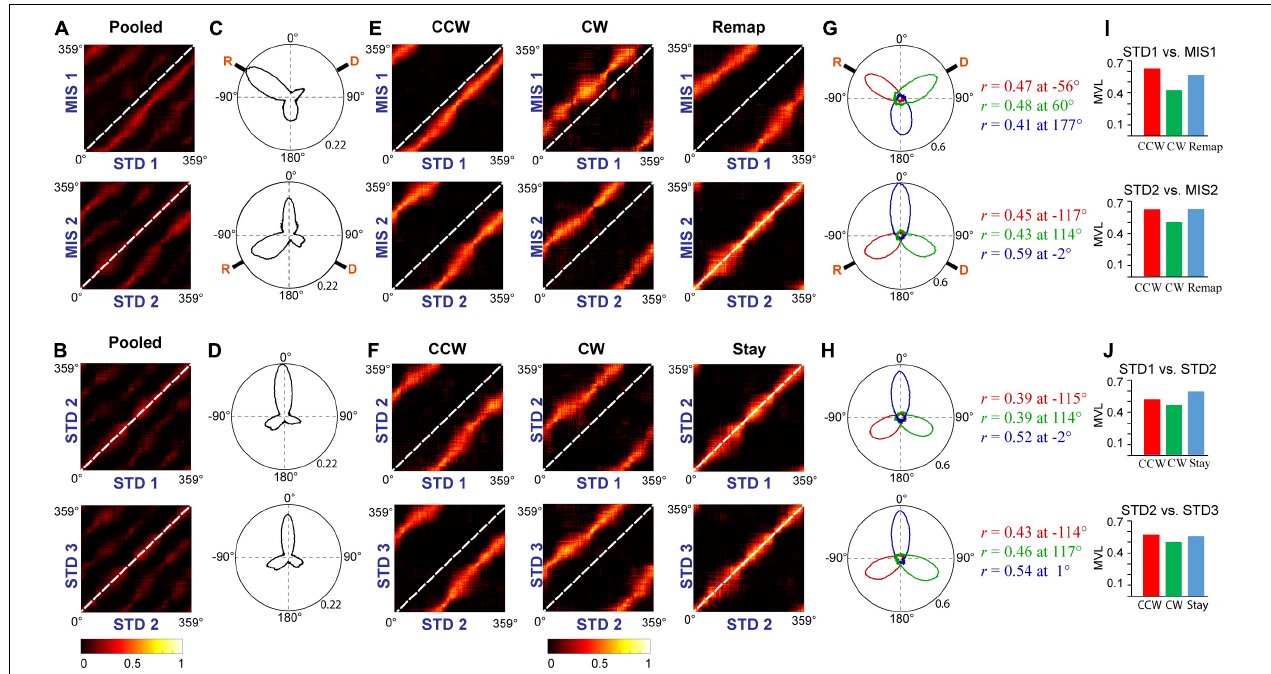
FIGURE 9 | Population response in the hippocampus. (A,B) Correlation matrices from population firing rate vectors of all the cells pooled from each ensemble at each position on the track between STD vs. MIS (A) and STD vs. STD sessions (B) . (C,D) The hippocampal population activity from panels (A,B) is represented as polar plots in panels (C,D) , respectively. (E,F) Grouped correlation matrices from population firing rate vectors of all the cells present in each cluster of ensembles at each location on the track between STD vs. MIS (CCW, CW, and Remap) and STD vs. STD sessions (CCW, CW, and Stay). (G,H) The hippocampal population activity of different groups between STD vs. MIS sessions [CCW (red), CW (green), and Remap (blue)] and STD vs. STD sessions [CCW (red), CW (green), and Stay (blue)] are represented as polar plots (constructed from correlation matrices). The values next to the polar plot indicate the angle of peak correlation (r) of the hippocampal population at corresponding groups. (I,J) Length of the mean vector in each group in STD vs. MIS and STD vs. STD sessions for each of the corresponding polar plots is shown in panels (G,H)